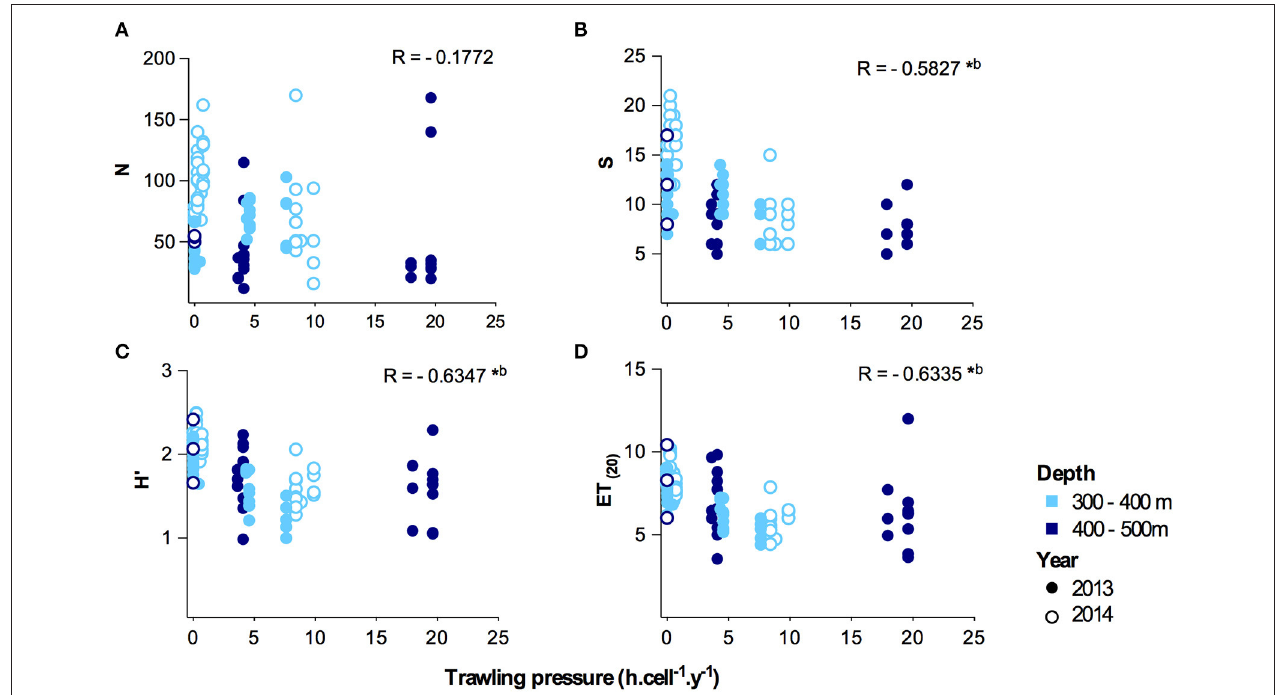
FIGURE 6 | Relationship between annual trawling pressure (h.cell − 1 .y − 1 ) and (A) abundance (N; ind.100m − 1 ) (B) morphospecies richness (S), (C) Shannon-Wiener diversity index (H ′ ) and (D) ET (20) Hulbert’s expected number of taxa for 20 individuals per depth range. *Indicates significant correlation; b Indicates significant correlations after Bonferroni